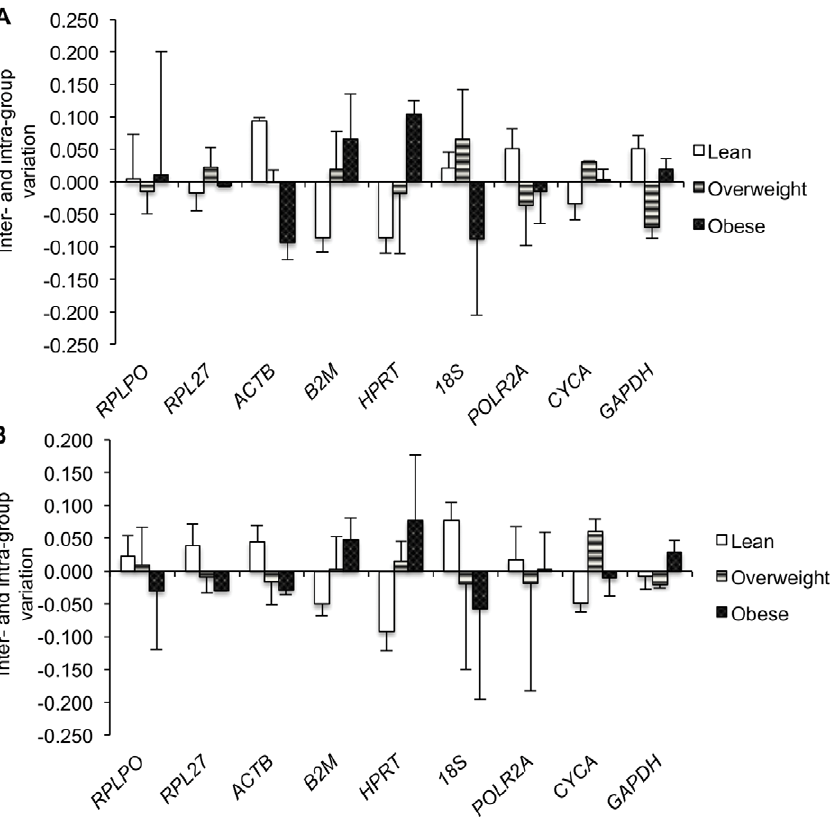
Figure 2. Validation of candidate genes using Normfinder algorithm. Inter- and intra-group variation of each candidate gene for (A) n=12 and (B) n=33. Columns represent the inter-group variation, whereas the error bars represent the intra-group variation for each candidate gene.